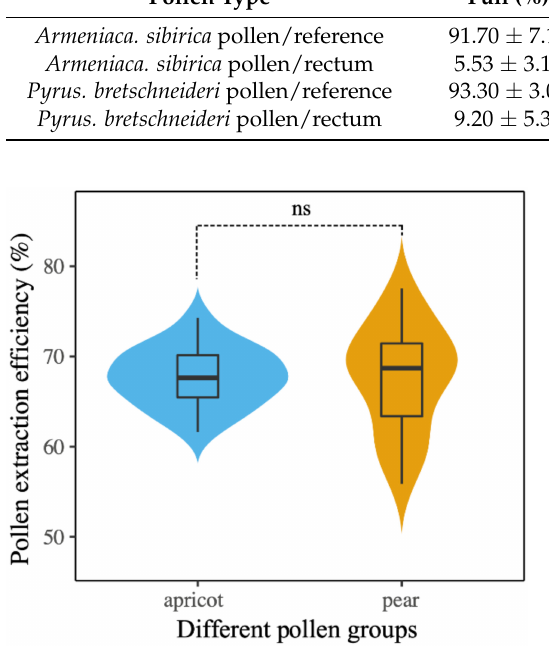
Figure 3. Pollen extraction efficiency for apricot pollen and pear pollen in the rectum of Apis. mellifera workers. Violin plots showing these results; the violin shape shows the distribution of the values, and there is a box plot inside. The black line in the center indicates the median, the top of the black box represents the upper quartile, the bottom of the black box represents the lower quartile, and ns means no significance ( p >